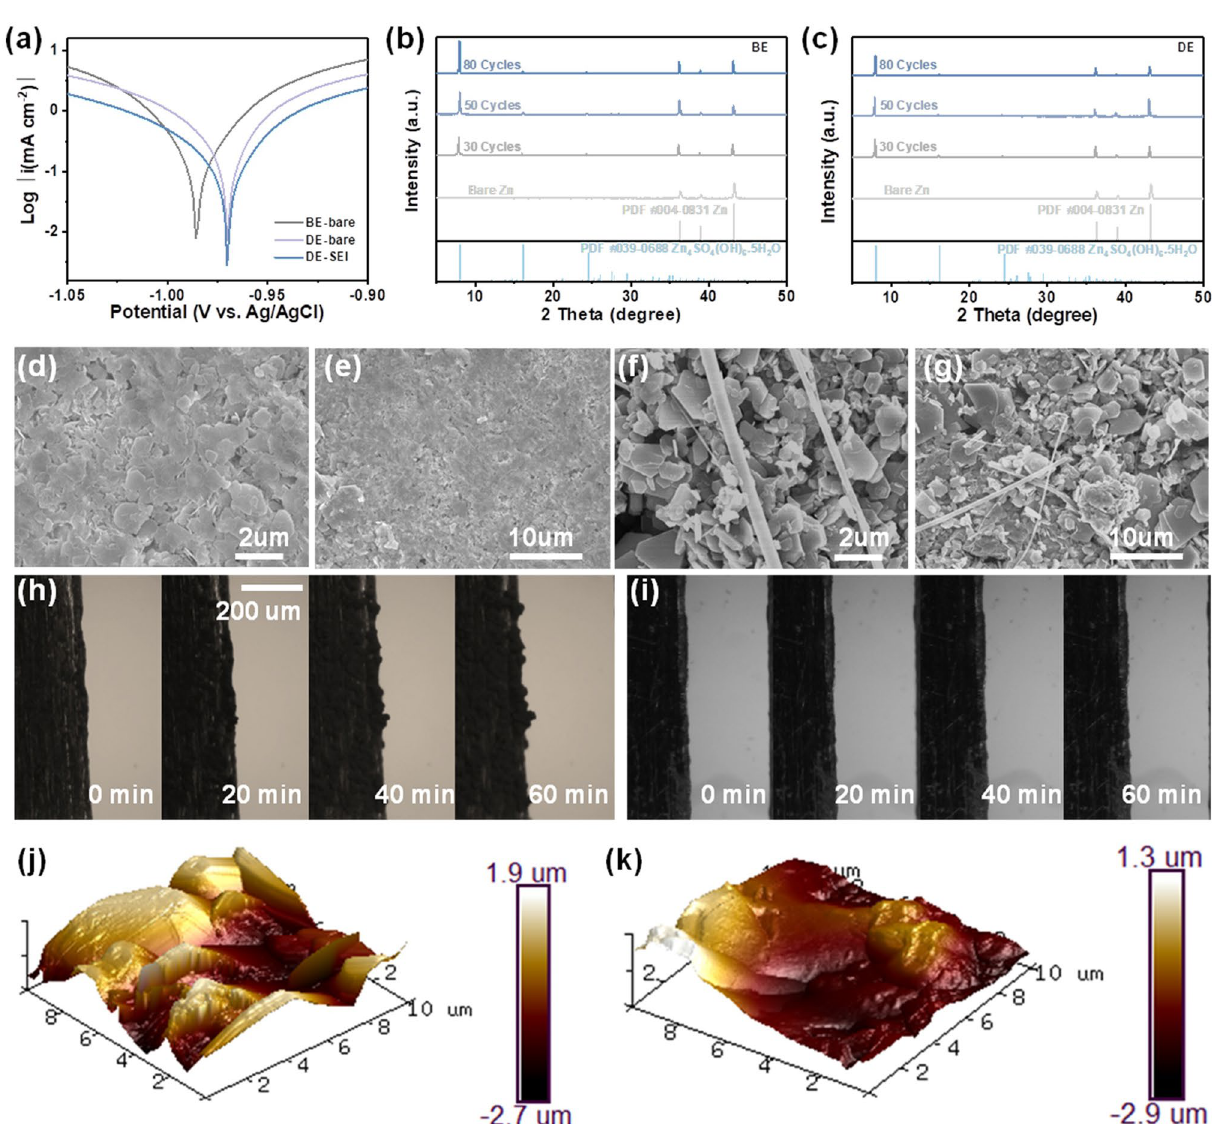
Fig. 3 a Linear polarization curves. b XRD patterns of Zn anode after cycled in BE. c XRD patterns of Zn anode after cycled in DE. d–e SEM images of Zn anode after cycled in DE at high and low magnifications, respectively. f–g SEM images of Zn anode after cycled in BE at high and low magnifications, respectively. h In situ observation of Zn plating in the Zn//Zn cell with an BE. i In situ observation of Zn plating in the Zn// Zn cell with an DE. j AFM image of the Zn anode surface after cycled in BE. k AFM image of the Zn anode surface after cycled in